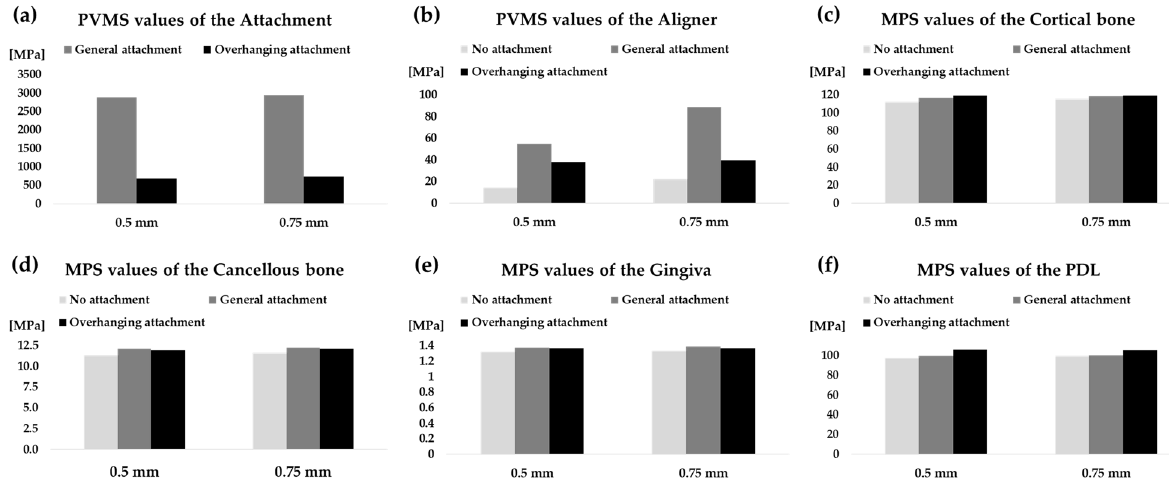
Figure 7. PVMS values measured in the aligner and attachment, and MPS values measured in the cortical bone, cancellous bone, gingiva, and PDL for both 0.5-mm and 0.75-mm-thick aligner models. ( a ) Attachment; ( b ) aligner; ( c ) cortical bone; ( d ) cancellous bone; ( e ) gingiva; ( f ) PDL.